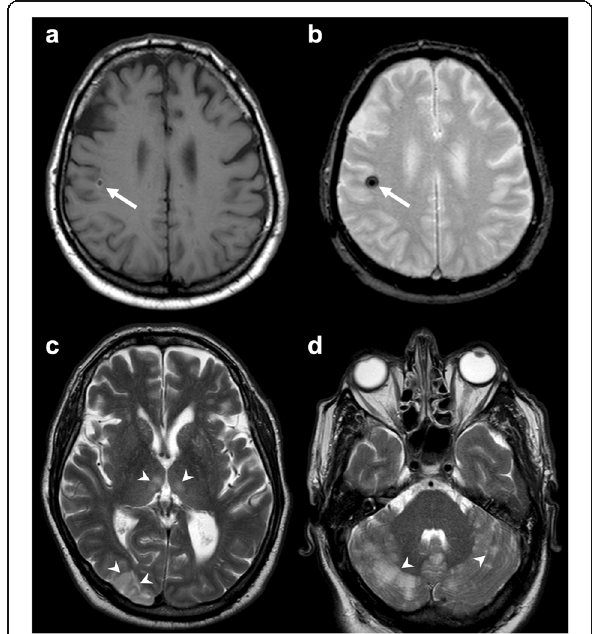
Fig. 10 Brain Teflon embolism. Axial T1-weighted ( a ), susceptibility- weighted ( b ), and T2-weighted ( c , d ) images depicting multiple ischemic lesions (arrowheads c , d ) due to Teflon emboli (arrow in a and b ) subsequent to aortic dissection surgery